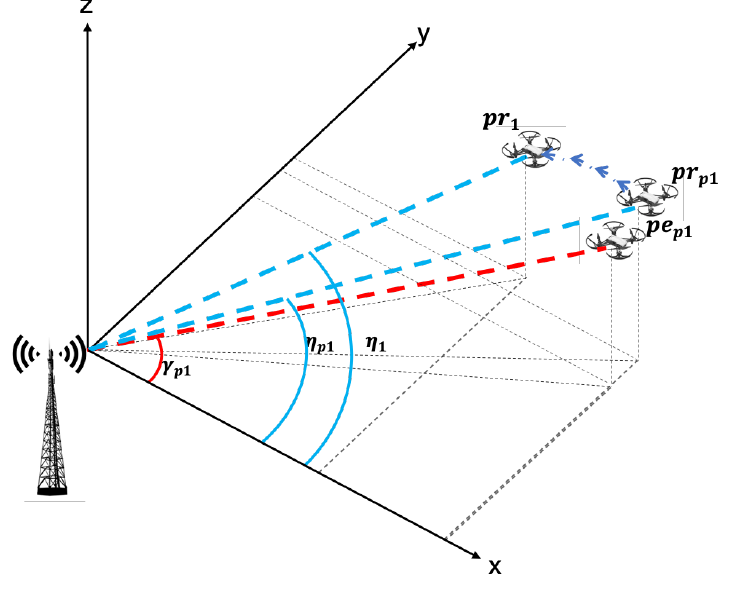
Figure 2. Illustration of the DoA estimation error caused by UAV’s mobility during pilot signal